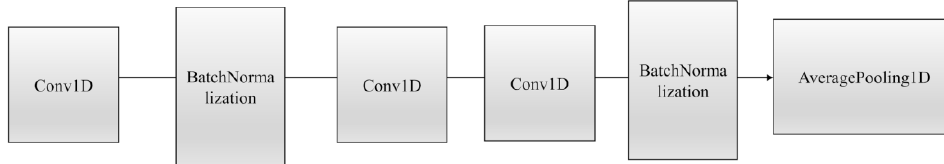
Figure 3. Optimized Inception-V1 structure.